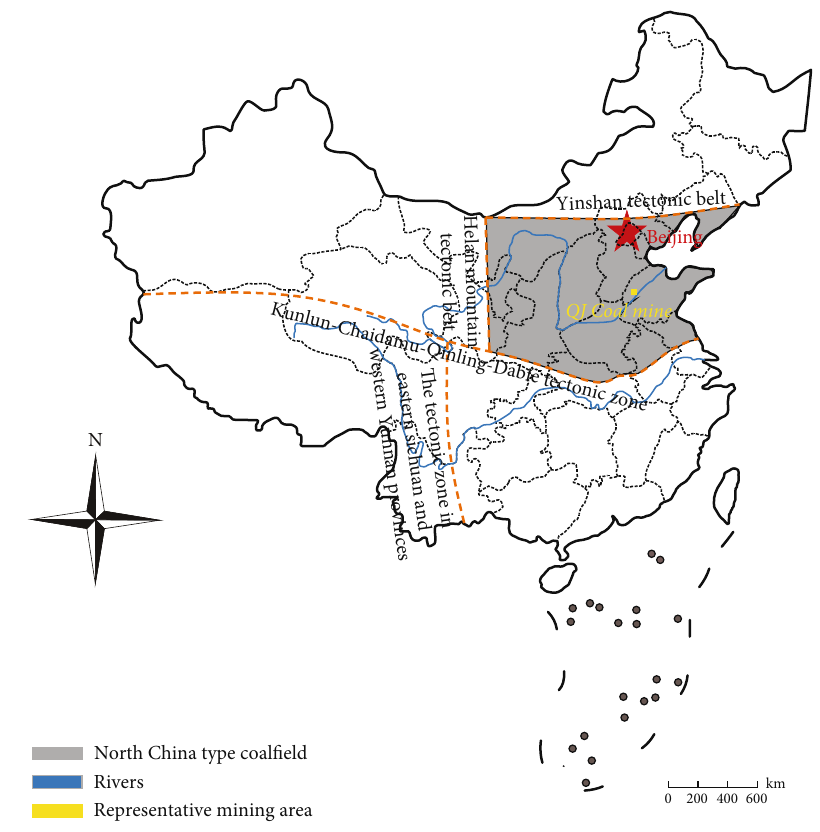
Figure 1: Regional location map of North China-type coal fi eld.